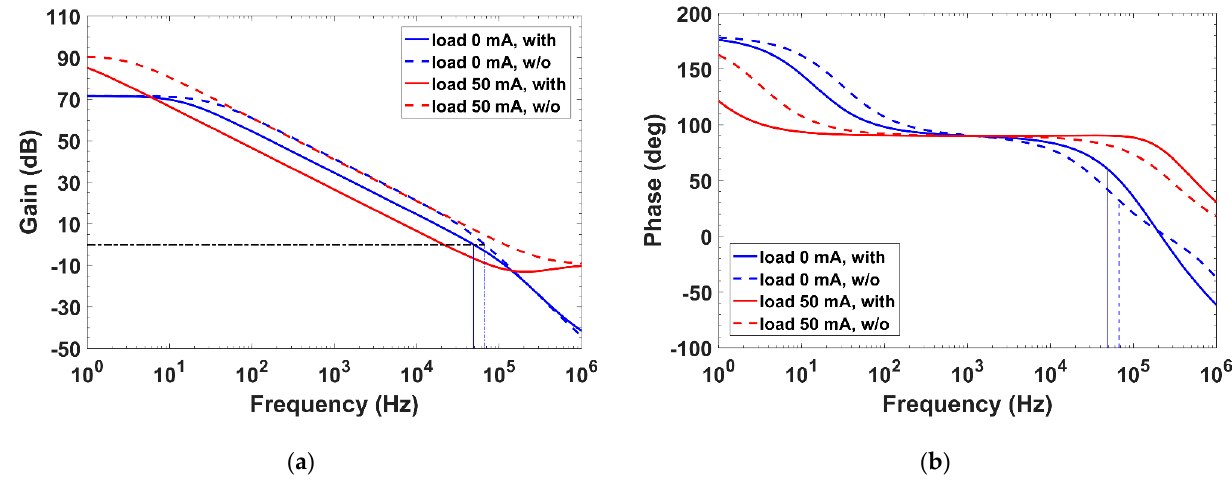
Figure 4. ( a ) Gain and ( b ) phase margin with (straight line) and w/o (dotted line) compensation for maximum I Load (50 mA, red) and minimum I Load (0 mA,